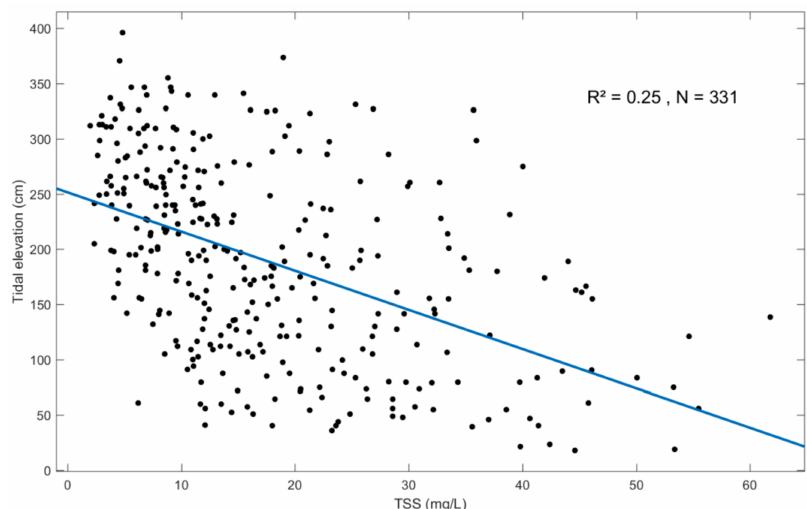
Figure 8. The relationship between Landsat-retrieved TSSs and tidal elevation.